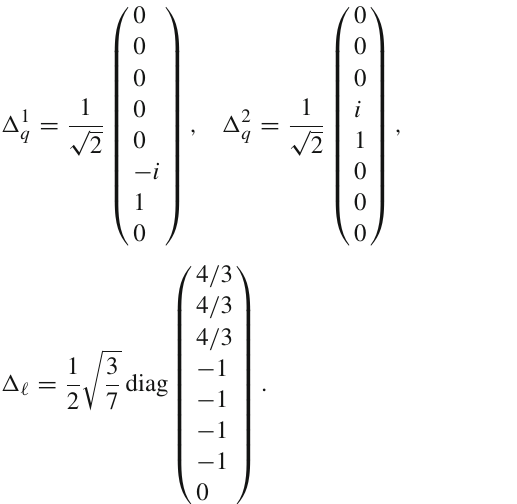
Since μ 2 (cid:7) ∼ f 2 (cid:18) λ H v 2 , the triplet does not take a VEV provided the underlying UV dynamics allows for a positive μ 2 (cid:7) (the same holds for the singlet if we weakly gauge the other SU ( 2 ) as discussed in Sect. 5, since the main contri- bution to the potential is still given by Eq. (2.24)). The main difference with respect to the scenarios explored before is that the relationship between μ (cid:7) and f is in principle not known. However, the same phenomenological study could be done having as an extra variable the ratio μ (cid:7) / f , which we leave for future